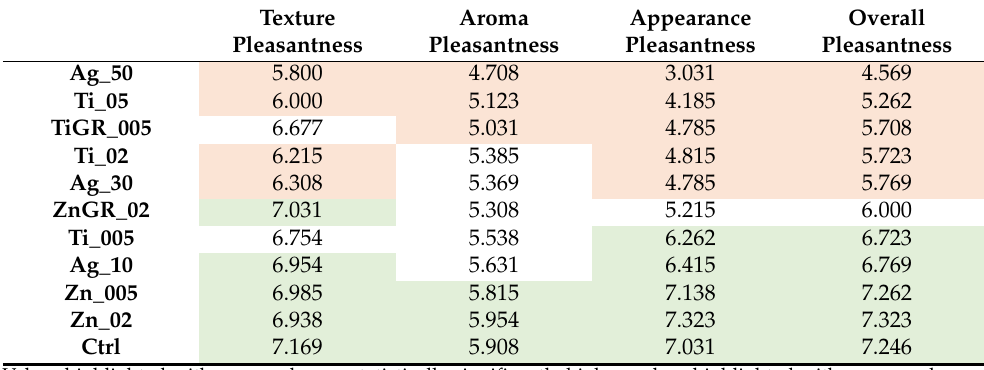
Figure 2. The PCA results of hedonic analysis of edible coatings: ( a ) Variables factor map. ( b ) Score plot for the mean points. Table 3. Adjusted mean scores of hedonic evaluation of edible coatings.